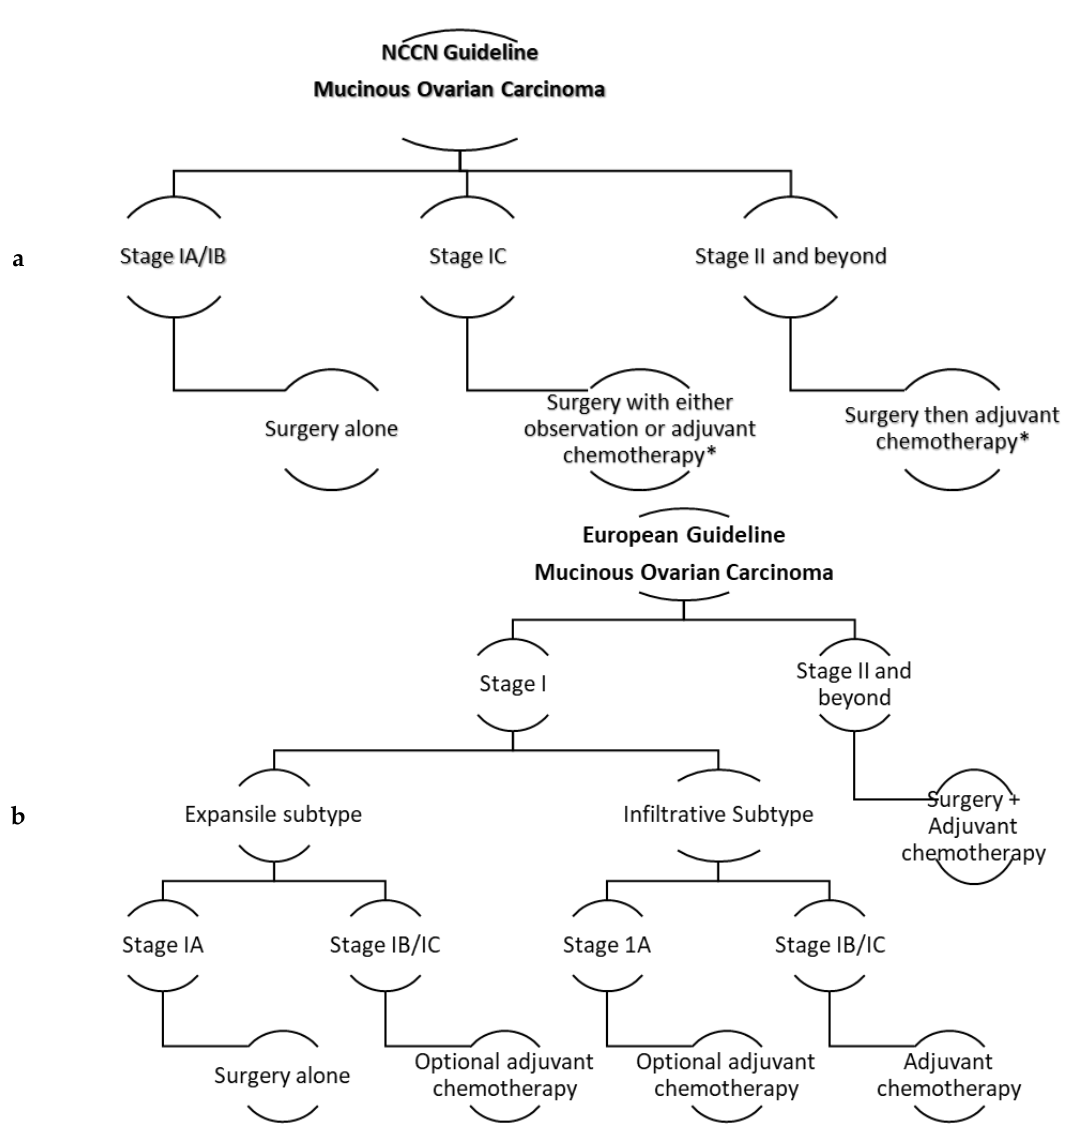
Figure 1. ( a ) The NCCN guideline for managing MOC. * Adjuvant chemotherapy is platinum-based, either carboplatin/paclitaxel or oxaliplatin with fluorouracil or capecitabine. ( b ) The European guidelines for managing MOC. * Adjuvant chemotherapy options are carboplatin/paclitaxel, xaliplatin with 5-FU, or capecitabine (anecdotally preferred). * Consider bevacizumab for either regimens (no clear evidence). *Consider neoadjuvant chemotherapy for unresectable biopsy-proven disease.